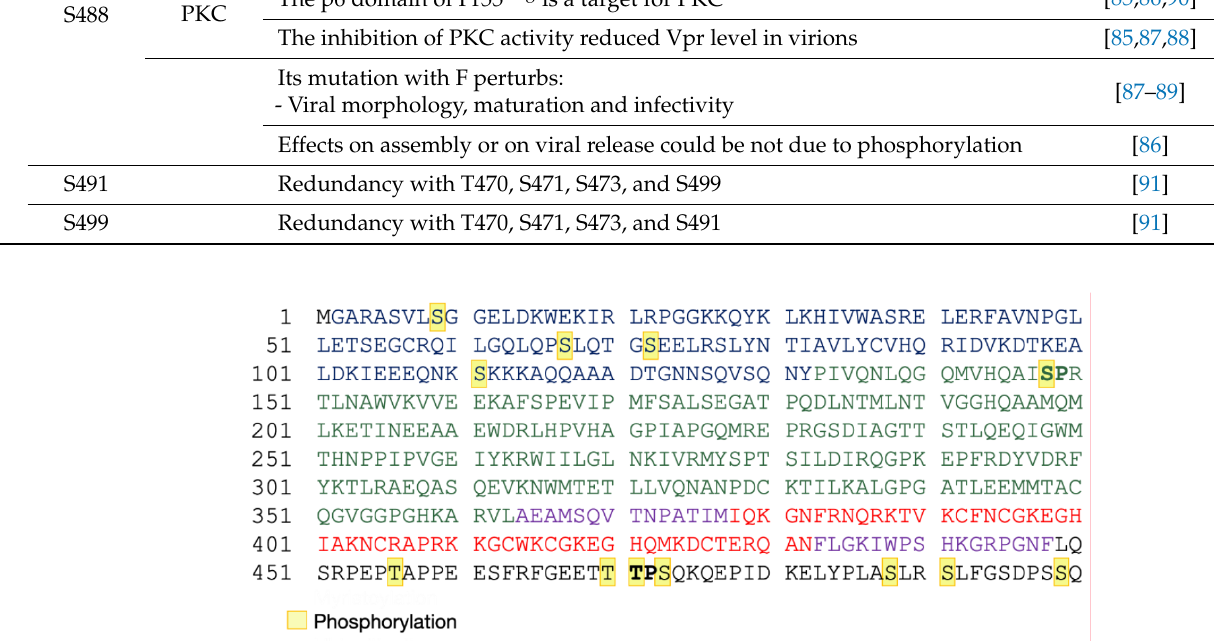
Figure 4. Phosphorylated residues in HIV-1 Pr55 Gag . The different colors represent the Pr55 Gag domains, MA (blue), CA (green), spacer peptides p1 and p2 (purple), NC (red), and p6 (black). Phosphorylation positions are highlighted in yellow. TP (in p6) and SP (in CA) motifs involved in the ERK2 recruitment and incorporation into viral particle are indicated in bold